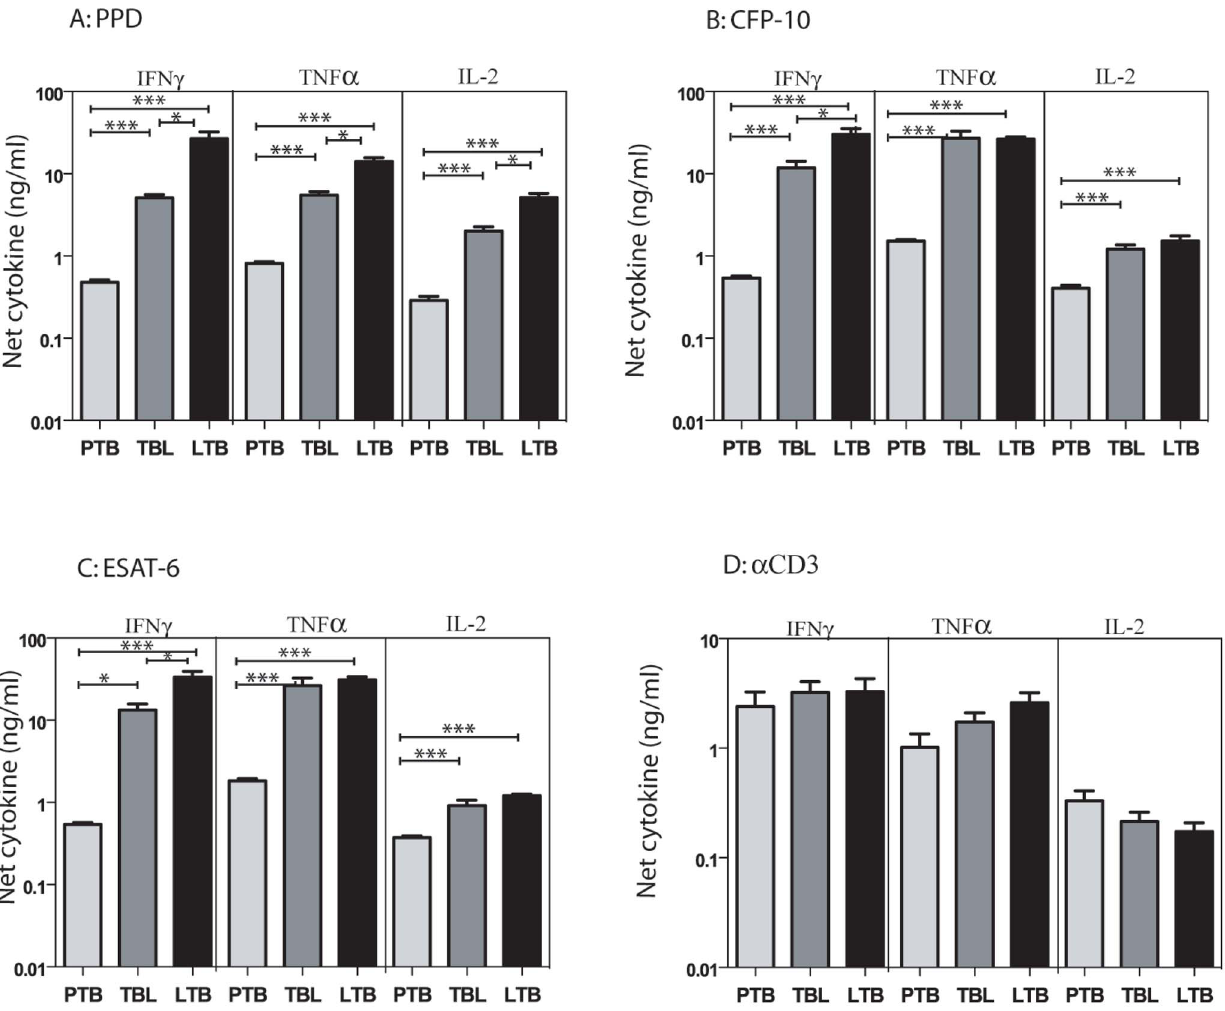
Figure 2. PTB is associated with decreased antigen-stimulated production of Type 1 cytokines. Whole blood from PTB, TBL and LTB individuals was stimulated with (A) PPD (10 m g/ml) or (B) ESAT-6 (10 m g/ml) or (C) CFP-10 (10 m g/ml) or (D) anti-CD3 (5 m g/ml) for 72 h, and levels of Type 1 cytokines IFN c , TNF a and IL-2 were measured by ELISA. Results are shown as net cytokine production over media control. The bars represent geometric means and 95% confidence intervals. P values were calculated using the Kruskal-Wallis test with Dunn’s multiple comparisons comparisons (* p , 0.05, ** p , 0.01, *** p , 0.001).